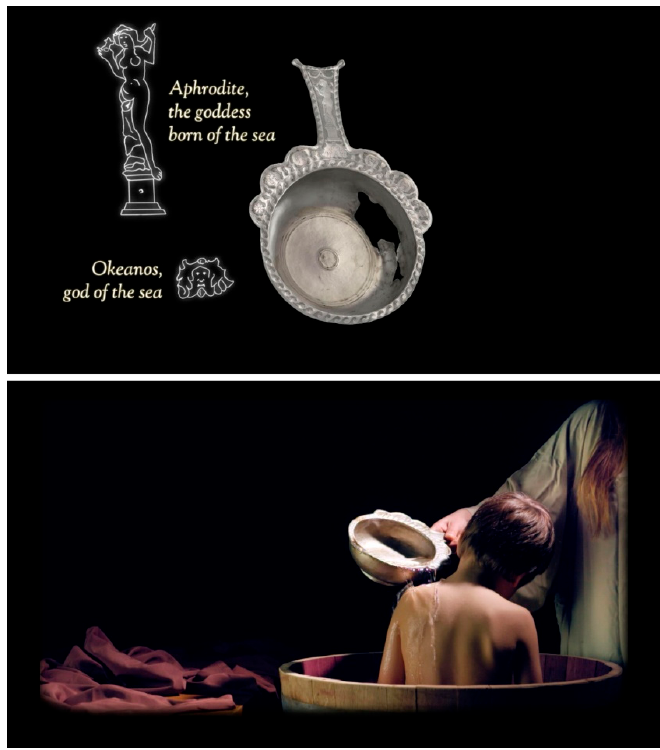
Figure 15. Mytilene treasure, two moments of the story regarding the trulla: explanatory and dramatized. (https://vimeo.com/285977554).